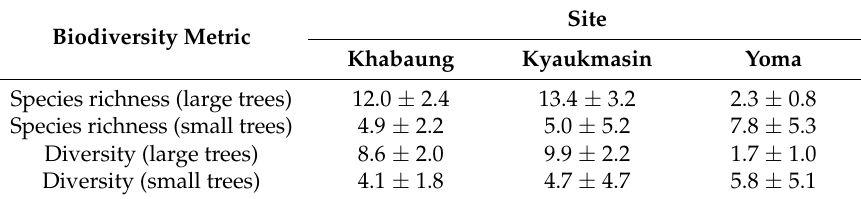
Table 2. Tree species richness and diversity (mean ± 95% confidence intervals) at the three sites measured using both large ( ≥ 20 cm DBH) and small (<20 cm DBH) trees. Diversity values are the effective number of species (the exponent of the Shannon diversity index), and can be interpreted on a linear scale.